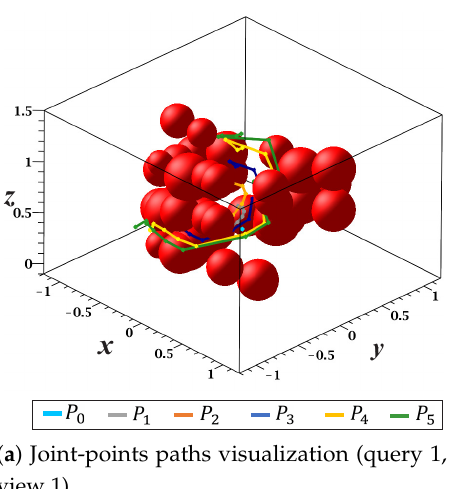
Figure 23. Collision-free path for a KUKA manipulator. Query 3, A =